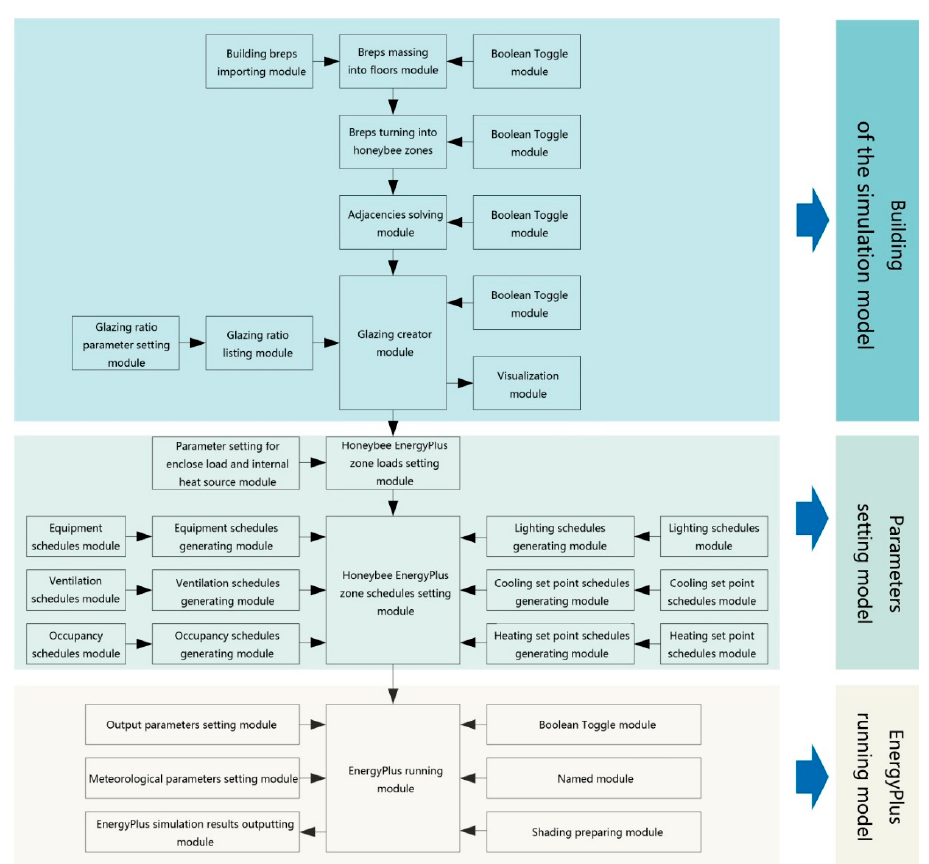
Figure 6. Components of the urban building energy simulation.